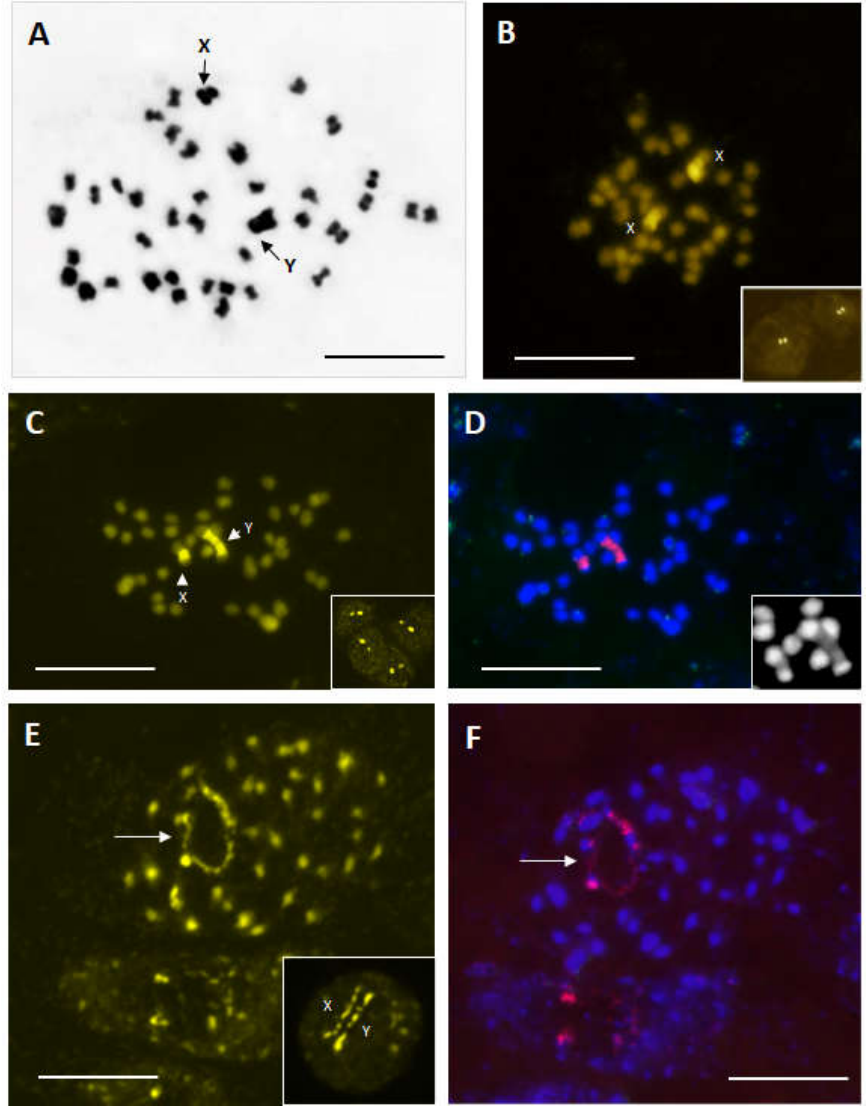
Figure 1. ( A – F ) orcein-stained metaphase of male individual (2 n = 40) with sexual chromosomes X and Y indicated by arrows ( A ). Chromomycin-stained metaphase and interphase nuclei (framed details) of female ( B ) and male ( C ) individuals. Note the strong difference in size of CMA signals in male individual ( C ). Same chromosome plate after FISH experiment. CMA signals were also strongly labelled with rDNA 35S probe ( D , red signals) but were DAPI negatives ( D , framed detail). Same prometaphase plate chowing activity of rRNA genes (arrows) stained by chromomycin ( E ) and after FISH ( F ). The beginning of decondensation of sex chromosomes at the early prophase ( E , framed detail). Bar = 10 µm.